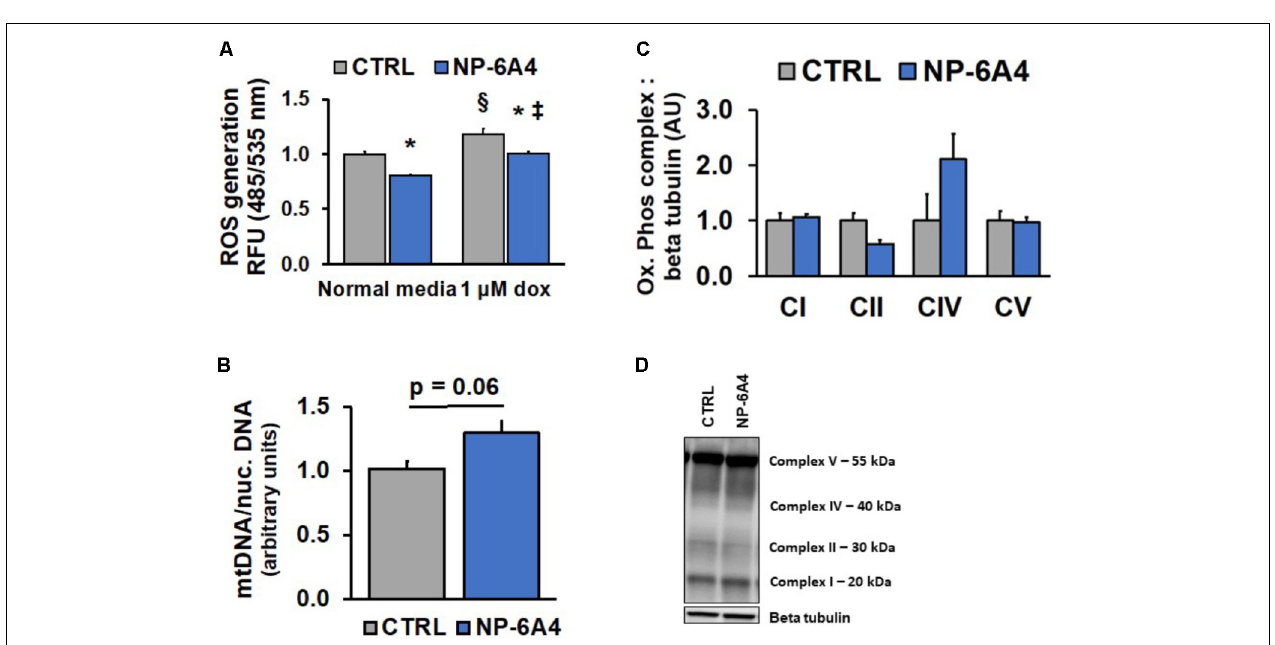
FIGURE 5 | NP-6A4 reduces reactive oxygen species while not altering mitochondrial number in hCAVSMCs. (A) Cellular ROS was increased with 1 µ M Doxorubicin, while 1 µ M NP-6A4 reduced ROS generation in both normal media and 1 µ M Doxorubicin. n = 4. (B) Mitochondrial DNA was non-significantly increased after 7 days of NP-6A4 treatment. n = 4. (C) Oxidative phosphorylation complexes quantification of Western Blot images. n = 3. (D) Representative image of the Western blot for oxidative phosphorylation complexes after 7-days of NP-6A4 treatment. ∗ Indicates p < 0.05 vs. CTRL using two-tailed Student’s t -test. § Indicates p < 0.05 vs. CTRL cells (normal media). ‡ Indicates p < 0.05 vs. NP-6A4 preTx cells (normal media). OCR, oxygen consumption rate; hCAVSMC, human coronary artery vascular smooth muscle cell.